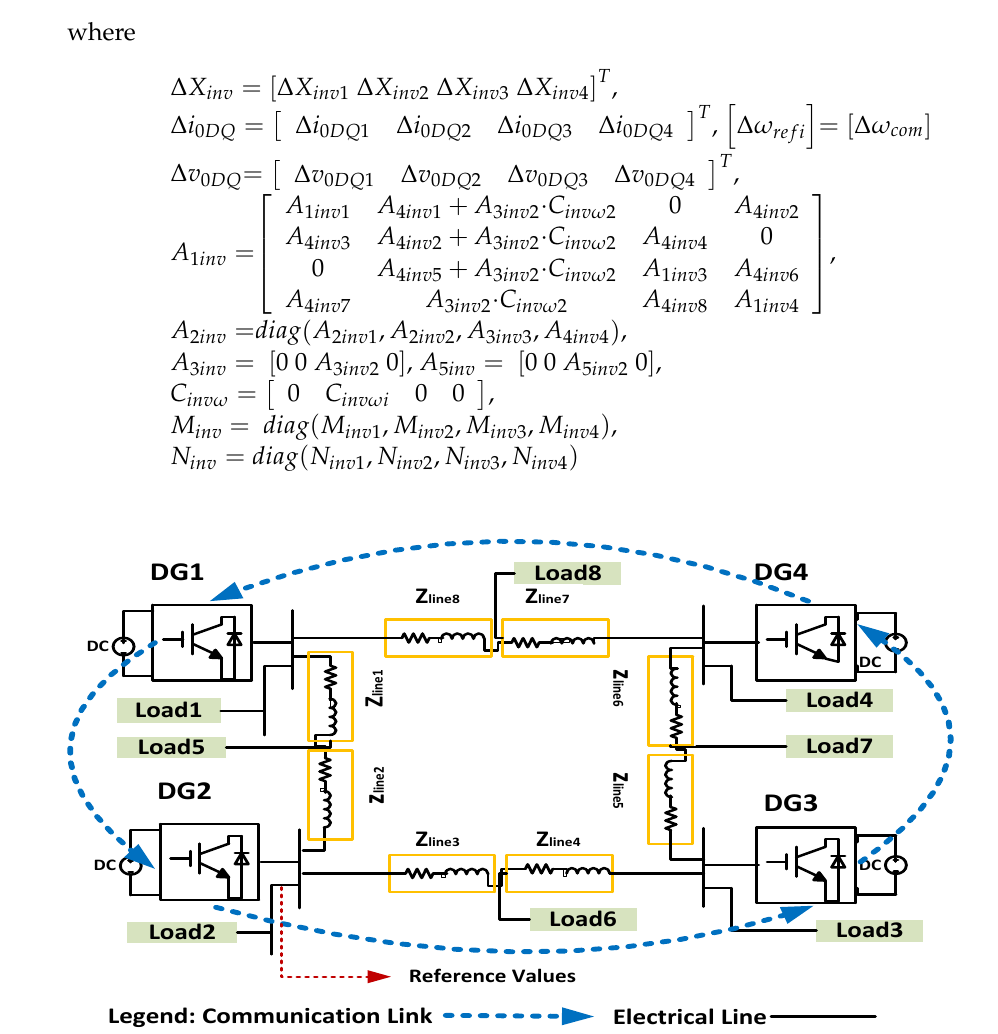
Figure 2. Single line figure of the microgrid (MG) test model with the communication